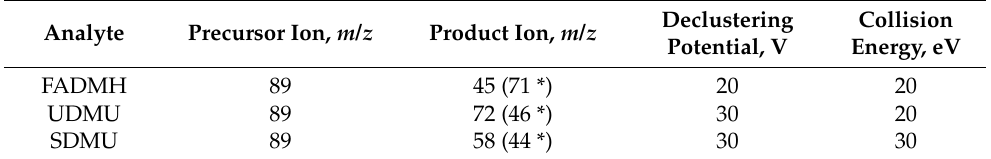
Table 2. Detection parameters in the multiple reaction monitoring mode.